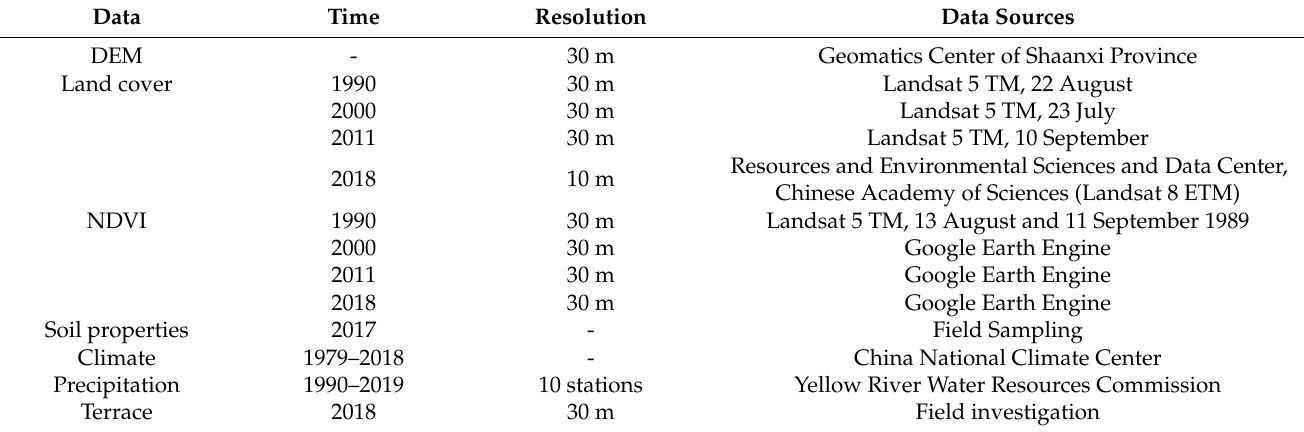
Table 1. Data used for land degradation assessment in the Huangfuchuan